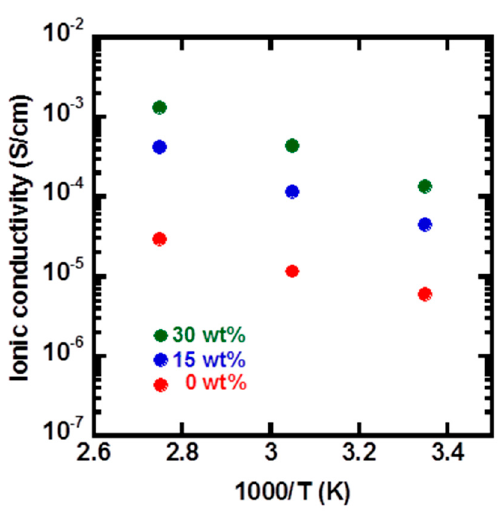
Figure 5. Temperature-dependent ionic conductivity of poly(NVI-NTf 2 ) 48 - b -poly(NIPAM) 52 containing different amounts of the ionic liquid (MEI-NTf 2 ).